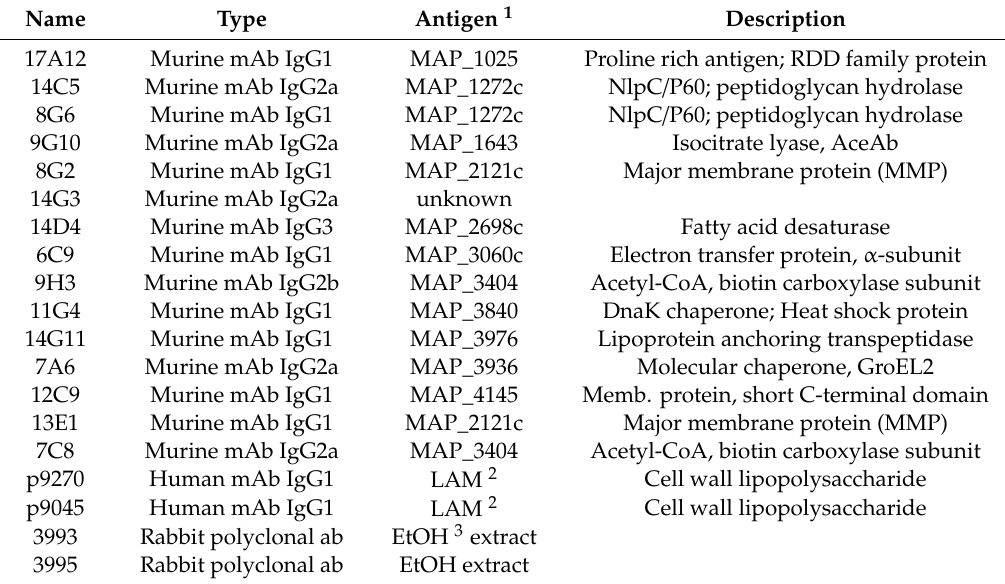
Table 1. Antibodies used in this